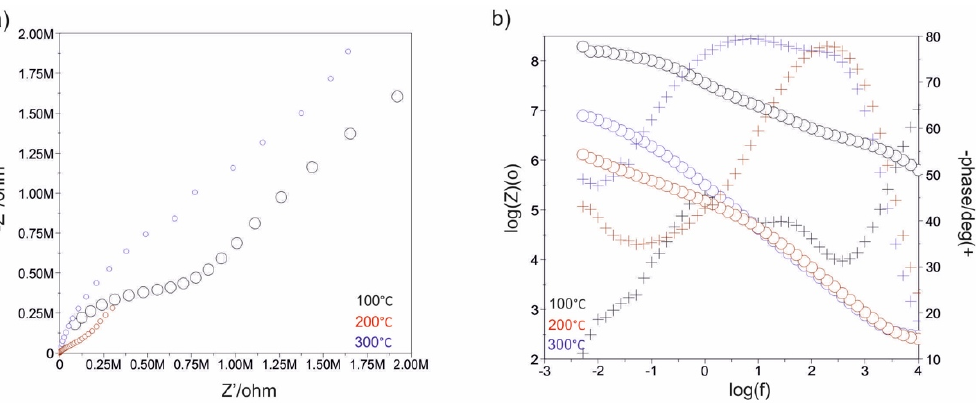
Figure 9. Impedance spectra determined for the ALD process in 1500 cycles for the sandblasted samples: ( a ) Nyquist diagram, ( b ) Bode diagram.